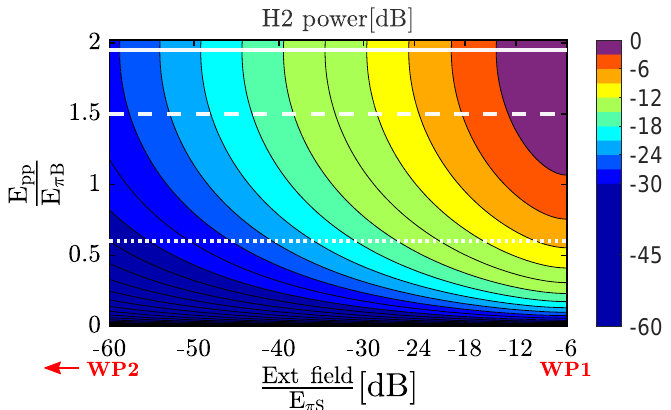
Figure 11. H2 power as a function of the external electric field and modulation amplitude. The solid, dashed and dotted lines indicates H2 power at constant amplitude modulation E pp = 2, 1.5, 0.6 E π B .